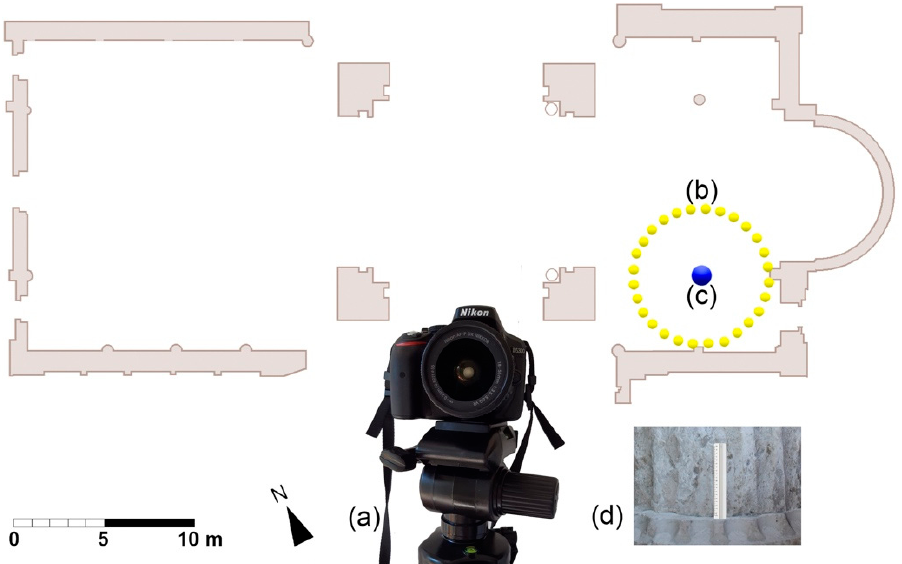
Figure 4. Plan of the Basilica of San Saturnino showing the scheme of the CRP survey of the investigated column. ( a ) Nikon D5300 digital camera used in this work; ( b ) camera positions (yellow circles in the figure); ( c ) studied column (blue circle); ( d ) calibrated bar introduced in the scene superimposed to the base of the studied column.